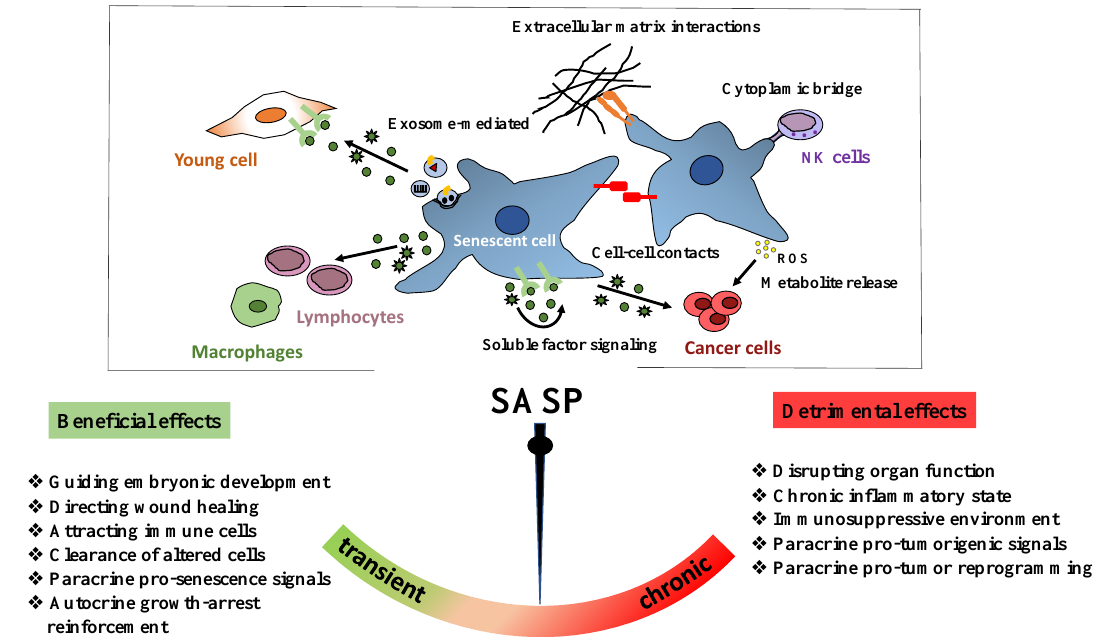
Figure 4. SASP signaling controls the beneficial and detrimental functions of senescent cells. Senescent cells through their secretome are actively engaged in cell-to-cell communications and extracellular matrix remodeling within the tissue microenvironment. The scheme depicts how senescent cells communicate via soluble factors, the release of extracellular vesicles (exosomes), cell–cell contacts, formation of cytoplasmic bridges, interactions with the extracellular matrix, and secretion of metabolites. It also lists some of the SASP-associated functions. A transient SASP is beneficial, while a chronic SASP causes negative outcomes. NK cells, natural killer cells; SASP, senescence-associated secretory